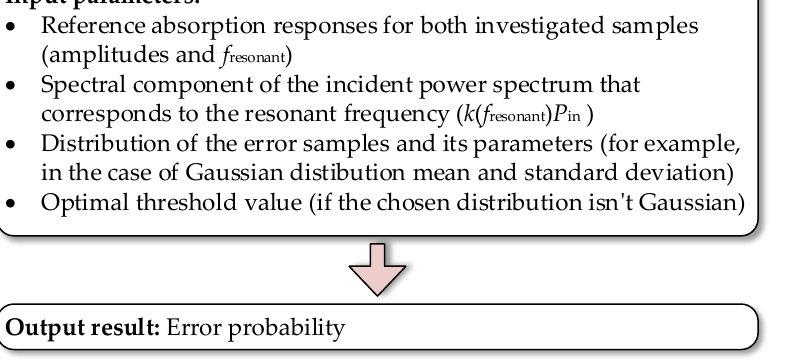
Figure 14. Input and output parameters of our error probability model (Octave script).